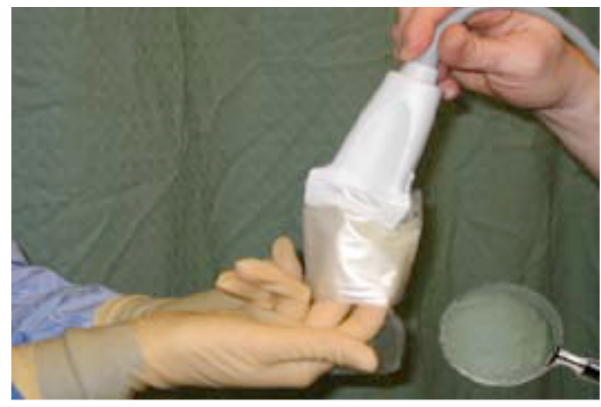
Figure 1. Ultrasound probe shown being sheathed using the current